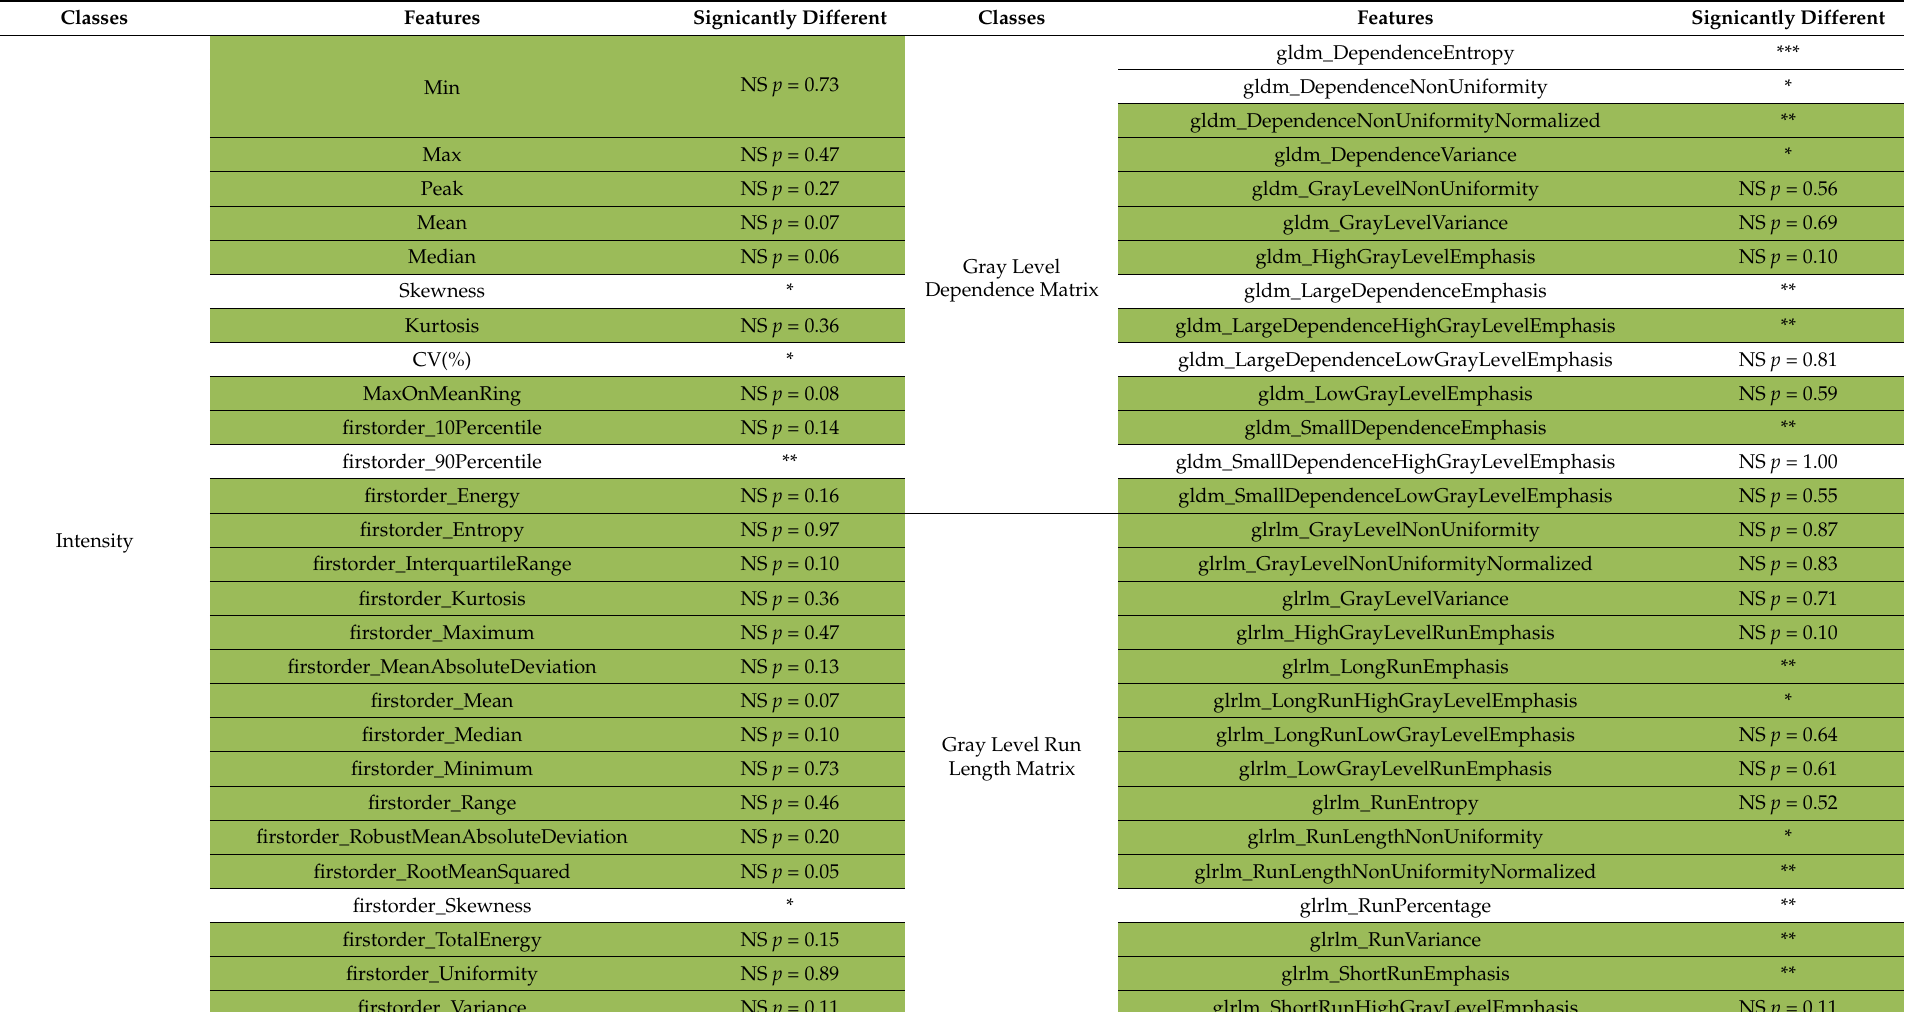
Table 2. Paired t -test, of DL resampling impact on radiomic features. Green highlight shows stable radiomic features values. * p < 0.05, ** p < 0.01 or *** p < 0.001 vs. features in the original